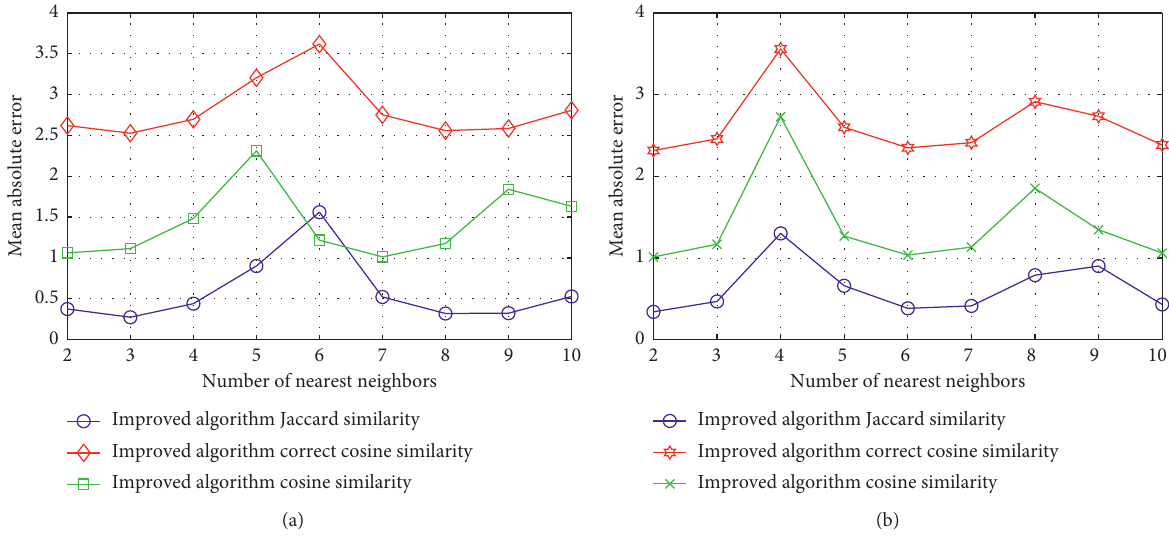
Figure 9: MAE experimental results of the NMFCF algorithm in this paper based on different similarity indicators. (a) Test result of the first user. (b) Test result of the second user.